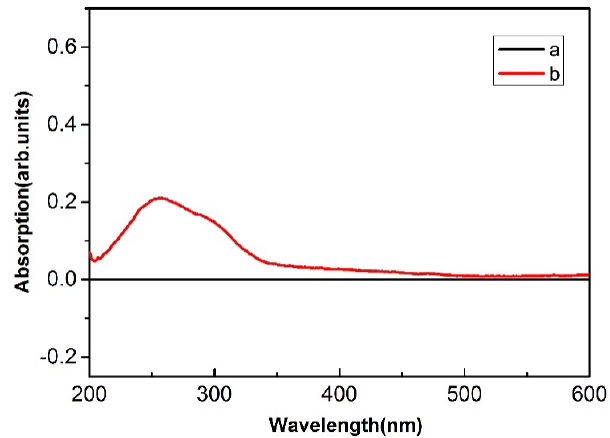
Figure 10. UV− Vis curves: ( a ) CF; ( b ) CF− TiO 2